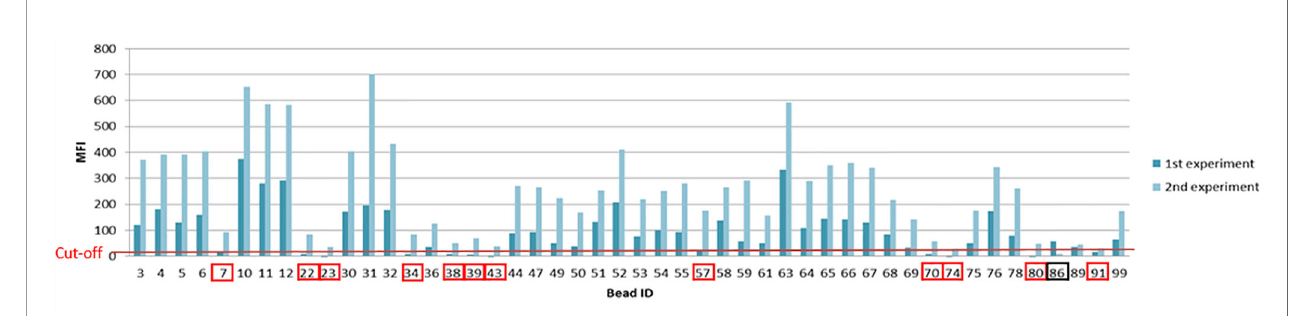
FIGURE 8 | Differences of MFI pro fi les and antigen speci fi city within one patient from two individual Luminex based experiments. Changes in antigen speci fi cities due to a difference in bead count are indicated by the red and black boxes (red= additional antigen speci fi city, black= loss of antigen speci fi city, from the fi rst to the